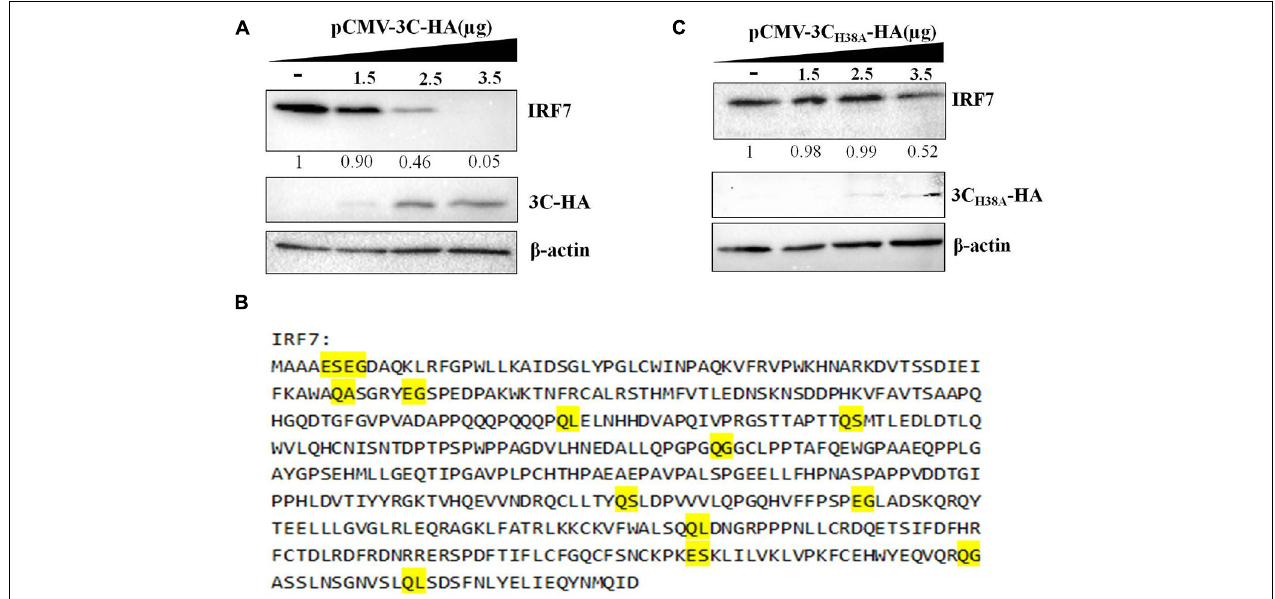
FIGURE 5 | Effect of the 3C protein on the IRF7 protein level. pCAGGS-IRF7-Flag (0.5 µ g) was cotransfected with different pCMV-3C-HA or pCMV-3C H 38 A -HA (the amount transfected into each group was 4 µ g, and pCMV-HA was used to supplement the insufficient group). Cell samples were collected at 36 h after transfection to detect the protein expression of IRF7. (A) Effect of the 3C protein on IRF7 protein expression in DEFs. (B) The possible cleavage site for the 3C protein in the amino acid sequence of the IRF7 protein. (C) Effect of the 3C protein lacking proteolytic enzyme activity on the protein expression of